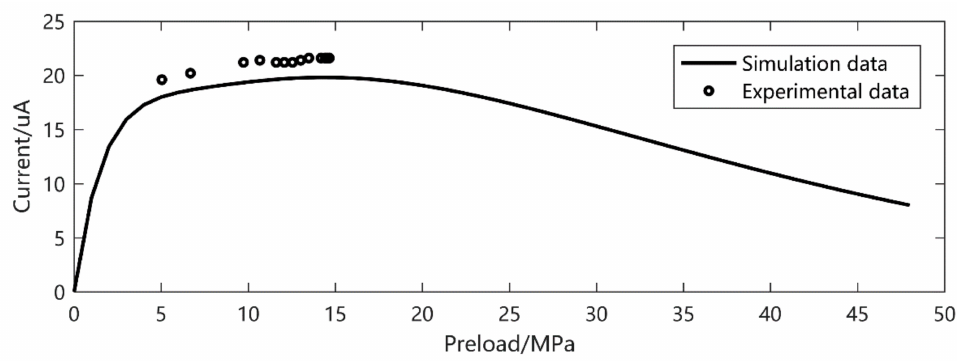
Figure 5. Frequency 30 Hz, excitation 11.76 MPa current output.